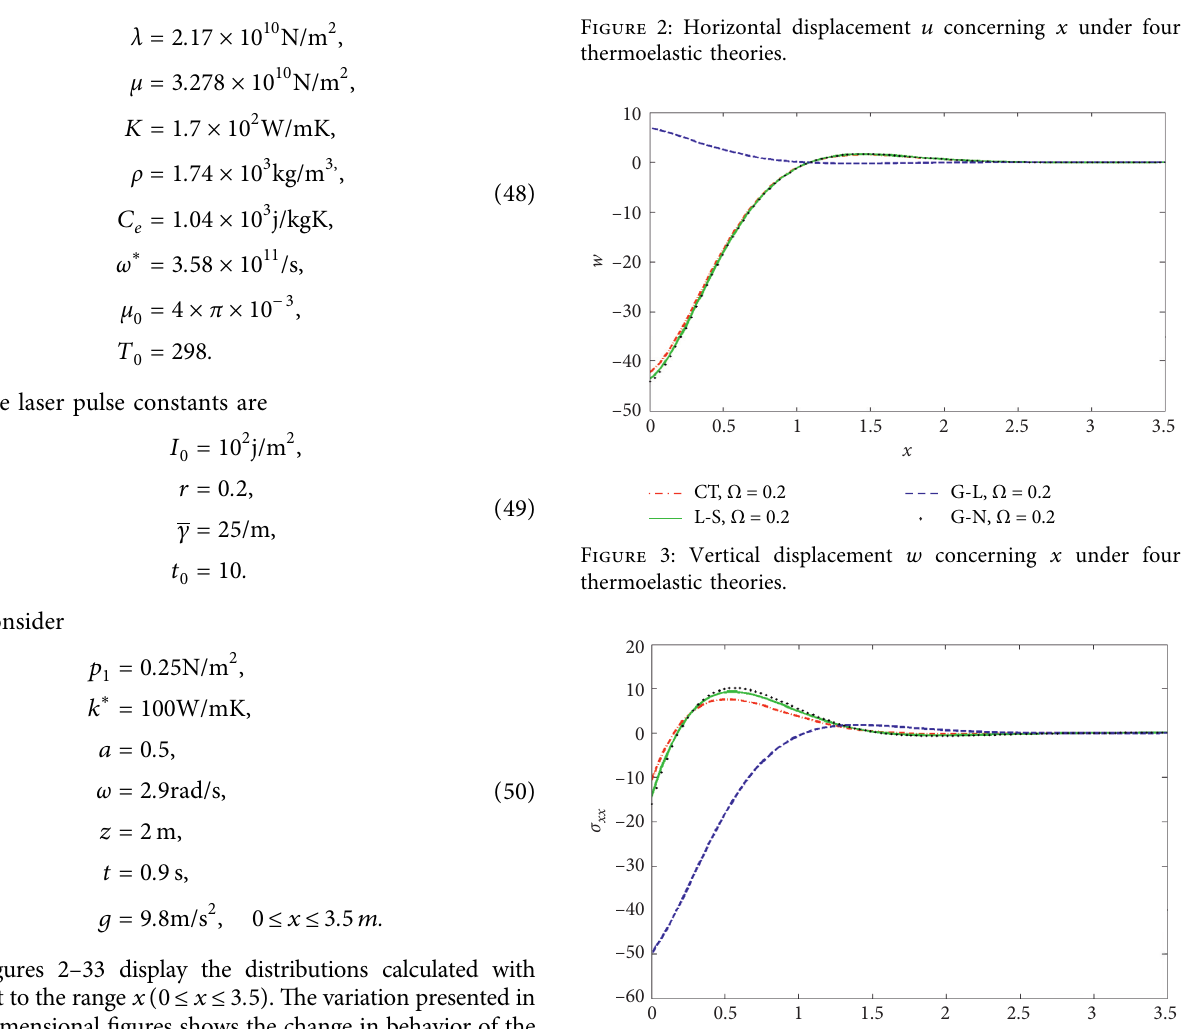
x under four thermoelastic